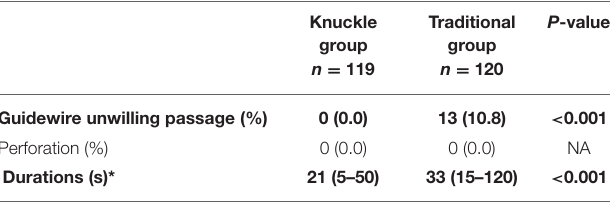
TABLE 3 | Baseline characteristics of safety and efficiency investigation. TABLE 4 | Endpoints of safety and efficiency